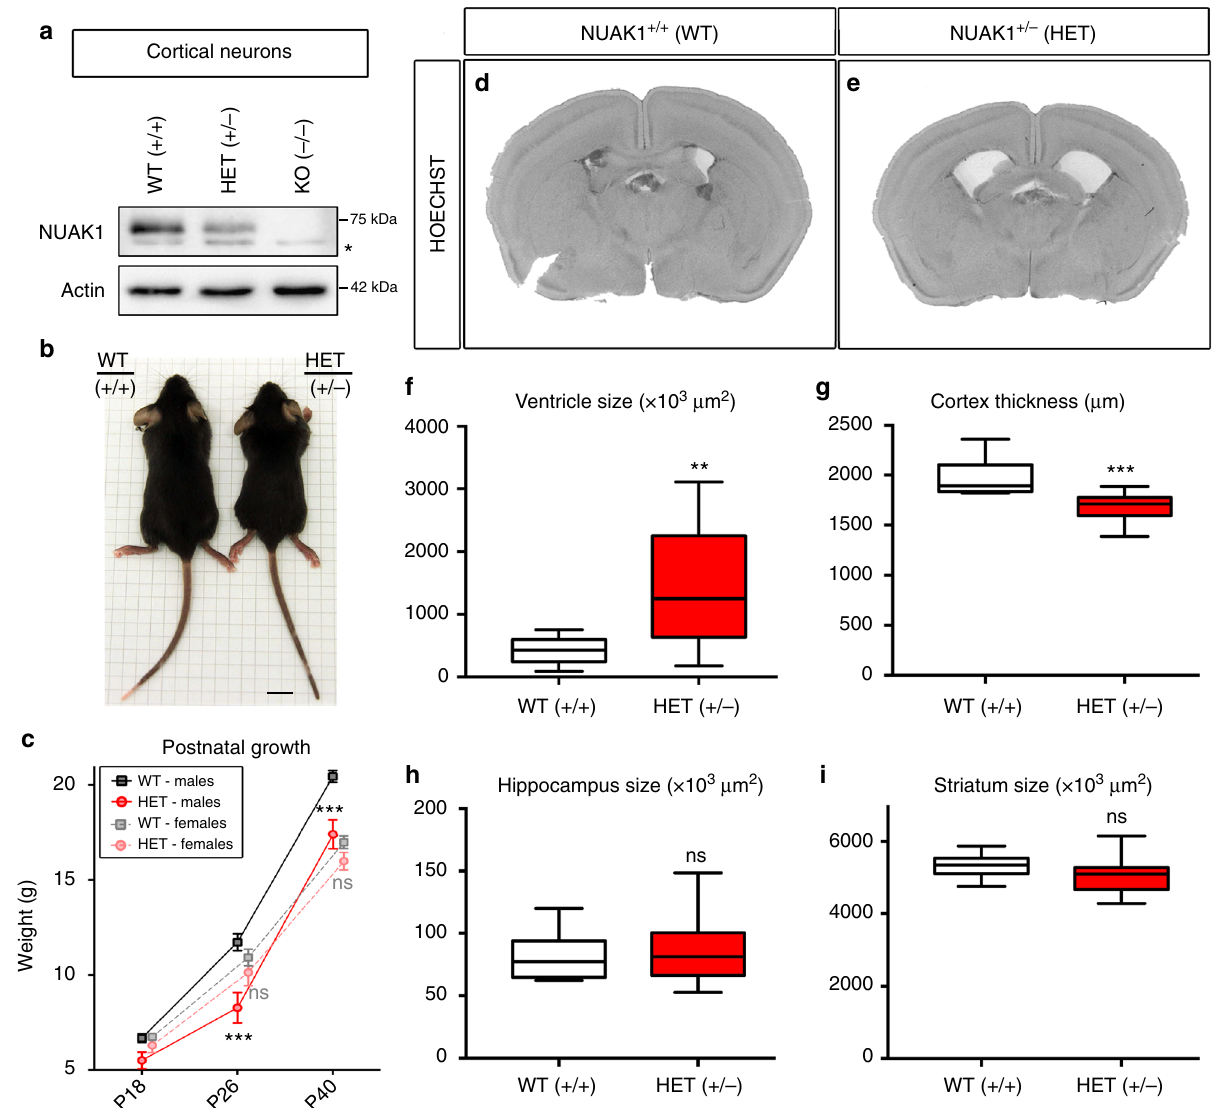
Fig. 1 Growth retardation and hydrocephaly in NUAK1 mutant mice. a Western-blot analysis of NUAK1 expression in 5DIV cortical neurons of WT, HET, and KO animals. The star indicates a non-speci fi c band. b Body size difference between males WT and HET NUAK1 mice at age P26. Scale bar 1 cm. c Postnatal body weight growth curve of WT and HET NUAK1 mice before (P18), or after (P26-P40) weaning. Average± SEM. N WT-females = 17, N HET-females = 14, N = 14, and N = 8. Analysis: 2-way ANOVA with Bonferroni ’ s multiple comparisons. d , e Representative coronal sections of P21 WT-males HET-males NUAK1 WT ( d ) and HET ( e ) mice stained with Hoechst dye. f – i Measurement of ventricle size ( f ), cortex thickness ( g ), hippocampus ( h ), and striatum size ( i ) from P21 coronal sections of NUAK1 WT and HET animals. Data represents min, max, median, 25 th , and 75 th percentile. Analysis: Two-tailed unpaired T -test. ( f , g , and i ) N WT = 10, N HET = 15. h N WT = 7, N HET = 13. ns: p > 0.05, ** p < 0.01, *** p <